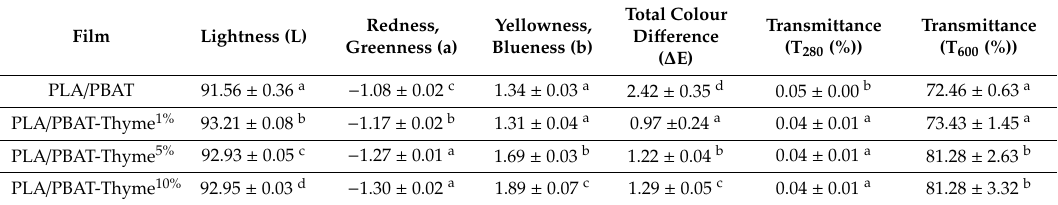
Table 1. Surface colour, UV barrier and transparency of composite films with Thyme oil.